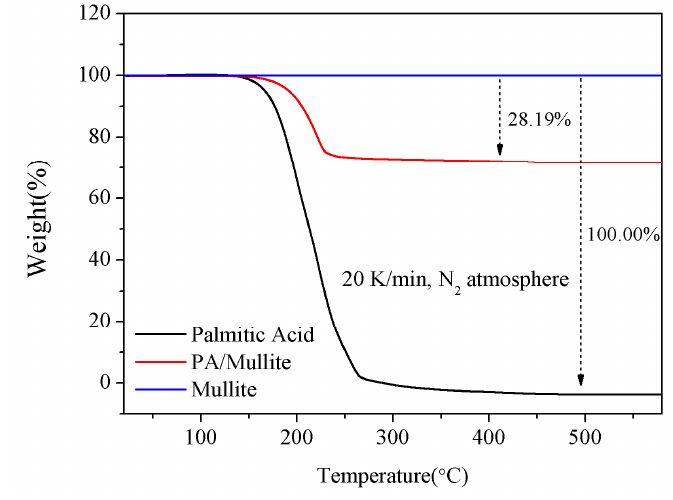
Figure 7. Thermogravimetry (TG) curves of the PA/mullite FSPCM.